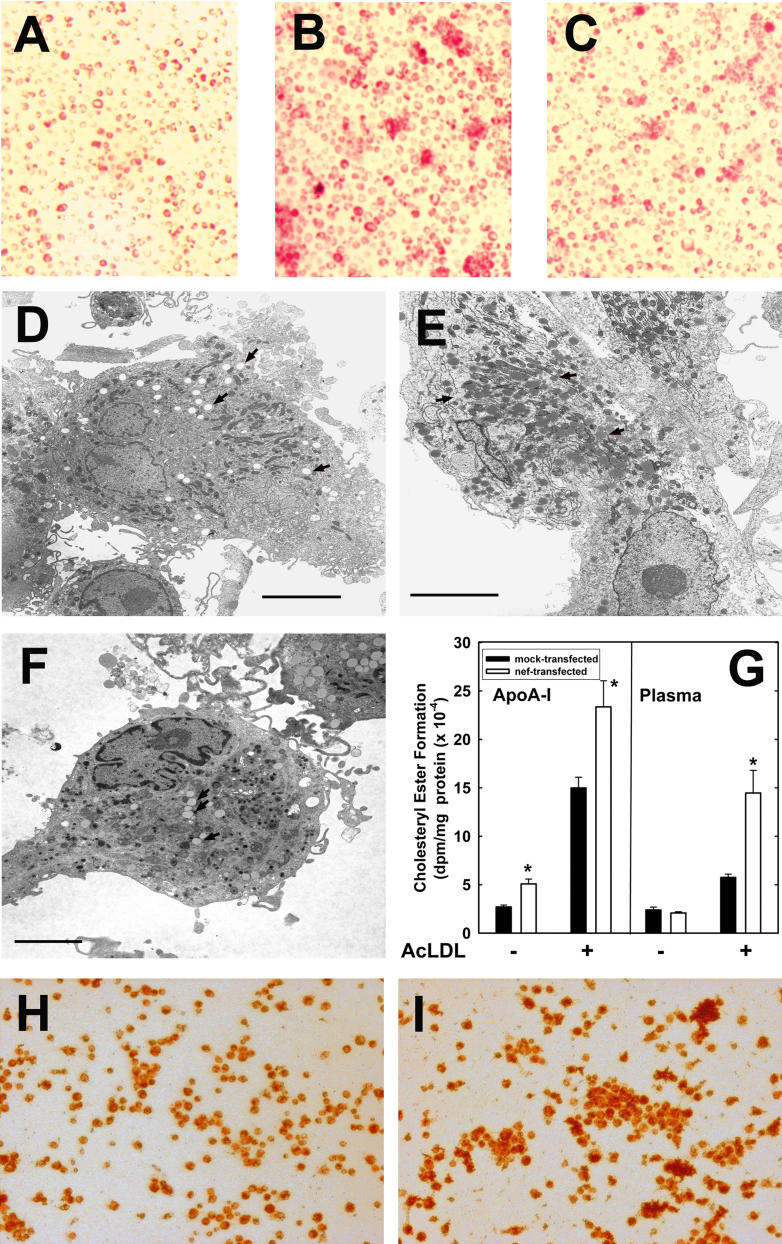
Accumulation of Lipids in Cells Infected with HIV-1 or Transfected with Nef(A–C) Oil Red O staining of HIV-infected macrophages. Uninfected (A) macrophages or cells infected with VSV-G–pseudotyped Nef-positive (B) or ΔNef (C) HIV-1 SF2 variants were loaded with cholesterol on day 3 after infection by incubating with AcLDL in the presence of apoA-I, and lipids were stained with Oil Red O 24 h later. p24 concentration in the culture supernatant on day 3 after infection was 4.7 ng/ml for cells inoculated with Nef-positive virus and 9.8 ng/ml for the culture inoculated with ΔNef HIV-1.(D–F) Electron microscopy of cholesterol-loaded uninfected macrophages (D) and cells infected with Nef-positive (E) and ΔNef (F) HIV-1 AD8 performed 14 d after infection. Uninfected cells have small numbers of electron-lucent lipid vacuoles (arrows). The cytoplasm of cells infected with Nef-positive virus is filled with electron-dense lipid vacuoles (arrows). Cells infected with ΔNef virus have small numbers of electron-lucent lipid vacuoles (arrows), similar in number to those in uninfected cells. The scale bars represent 5 μm.(G) The effect of Nef on cholesteryl ester synthesis. The rate of cholesteryl ester synthesis in RAW 264.7 cells transfected with an empty vector (mock-transfected) or Nef-expressing construct and incubated with or without AcLDL in the presence of apoA-I or 5% human plasma is presented as mean ± SD of quadruplicate determinations. An asterisk (*) indicates p < 0.02.(H) and (I) RAW 264.7 cells were transfected with empty vector (H) or Nef-expressing construct (I), stimulated with LXR agonist, incubated with AcLDL and lipid-free apoA-I, fixed with formaldehyde, and stained with Oil Red O.